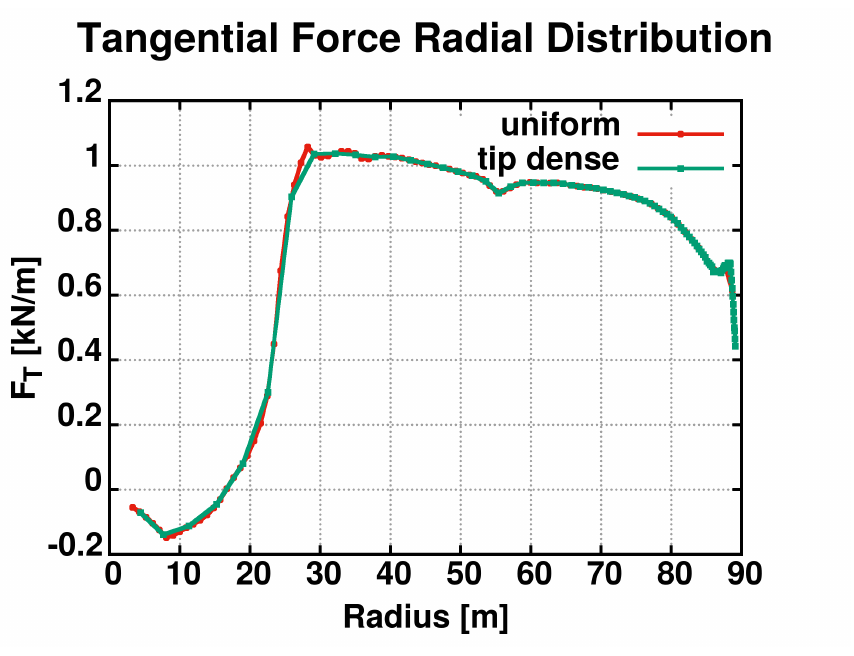
Figure 8. Tangential force radial distribution. Comparison of uniform and tip dense distribution of strips. Table 2. Variation of power [MW] with increasing blade grid size ∆ r [m]. Reference power corre- sponds to minimum value ∆ r = ∆ x